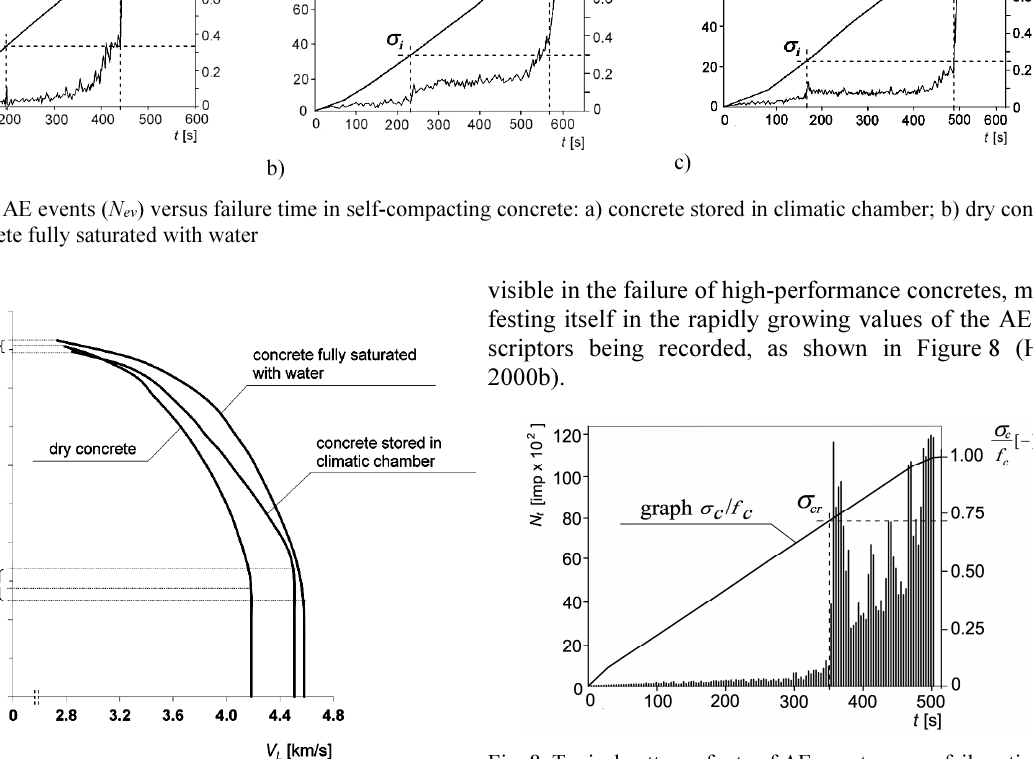
Fig. 8. Typical pattern of rate of AE events versus failure time for high-performance concrete (Hoła 2000b)